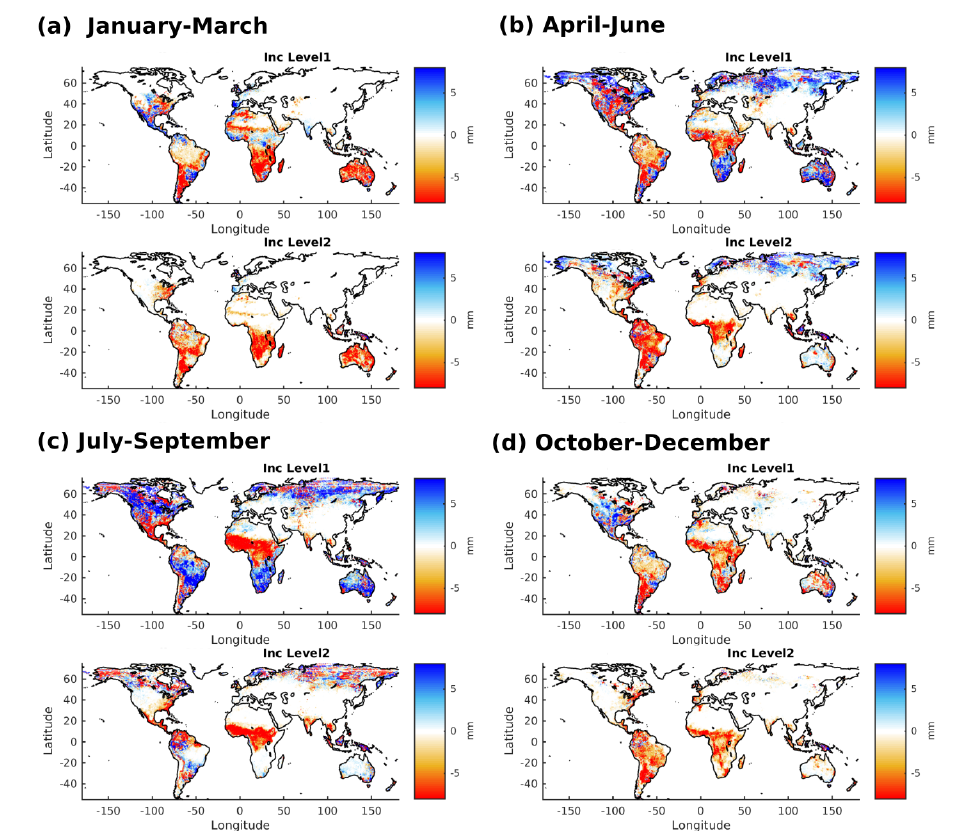
Figure 6. Increments for the upper two model layers for experiment NNSM. ( a ) Sum of the increments from January to March. ( b ) Sum of the increments from April to June. ( c ) Sum of the increments from July to September. ( d ) Sum of the increments from October to December.